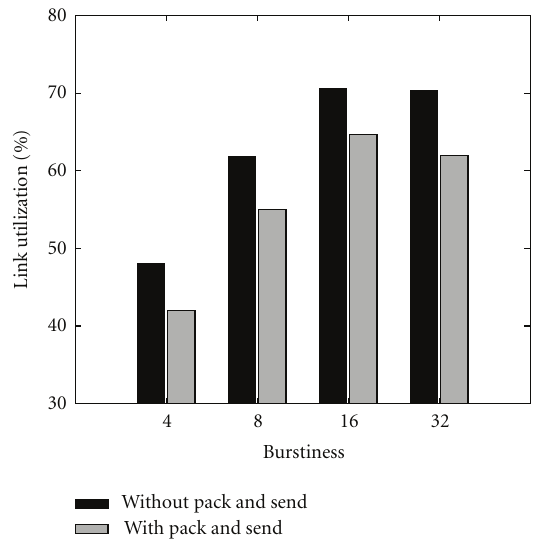
Figure 12: Pack and